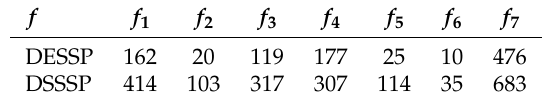
Table 11. Averages of processing time (in seconds) for running the DESSP and DSSSP